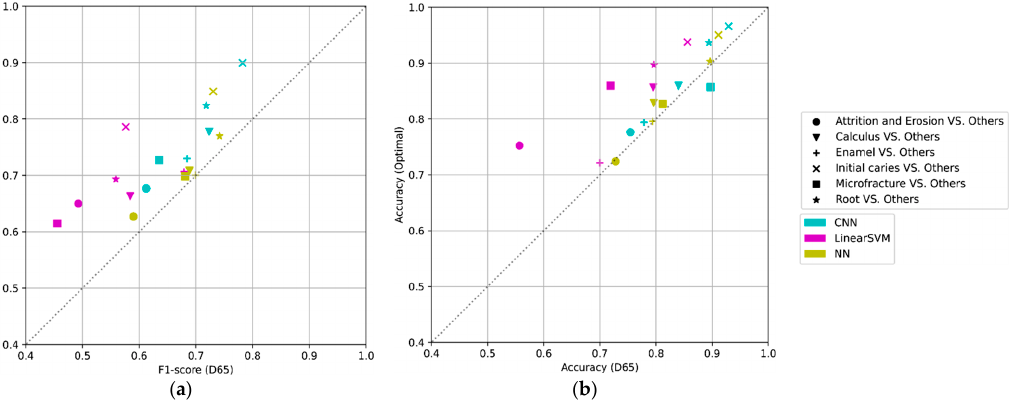
Figure 11. The comparison of performance between the reference (D65) vs. the optimal light in the five-fold cross-validation: alternating optimization (linear SVM), proposed method with only FCL (NN), and proposed method with CNN (CNN): ( a ) F1-score and ( b ) accuracy.